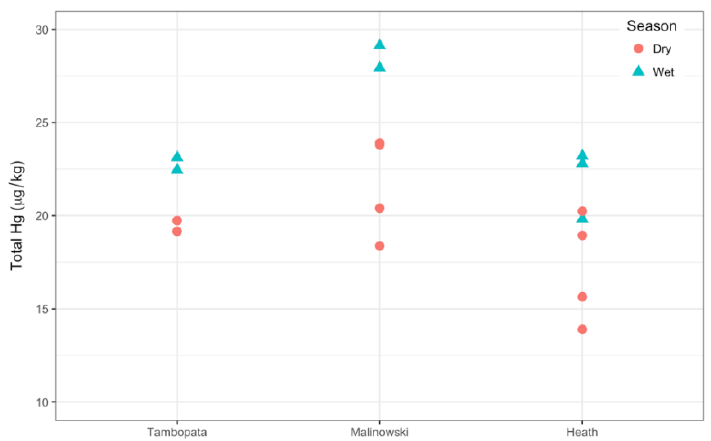
Figure 3. The % C-normalized Hg sed ( μ g/kg) for each river. Dry season Hg sed are shown with circles and wet season Hg sed are shown with triangles. All wet season Hg sed are higher than dry season Hg sed for each river, except one value in Heath River. An outlier collected directly from an ASGM-site was not included (Malinowski River = 367.2 μ g/kg).